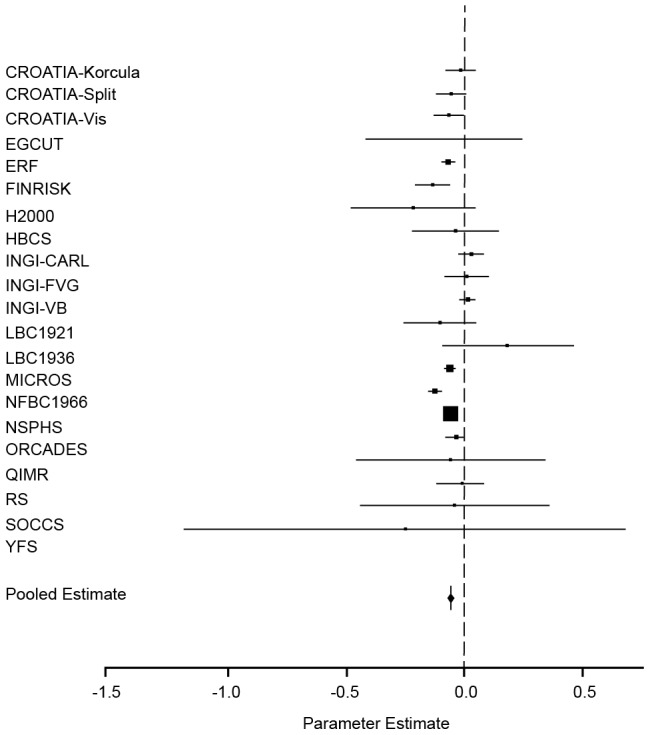
Forest plot of the effect of FROHLD on height.Results of a meta-analysis of the association between FROHLD and height are shown for twenty-one population samples. The model was adjusted for age and sex in all samples. Additionally, it was adjusted for genomic kinship in samples with pairs of related individuals (CROATIA-Korčula, CROATIA-Split, CROATIA-Vis, ERF, FINRISK, HBCS, H2000, INGI-CARL, INGI-FVG, INGI-VB, MICROS, NFBC1966, NSPHS, ORCADES and YFS). The plot shows estimated effect sizes (solid squares) for each population, with 95% confidence intervals (horizontal lines). Each sample estimate is weighted by the inverse of the squared standard error of the regression coefficient, so that the smaller the standard error of the study, the greater the contribution it makes to the pooled regression coefficient. The area of the solid squares is proportional to the weighting given to each study in the meta-analysis. Effect sizes in z-score units (with 95% confidence intervals) are: CROATIA-Korčula = −0.02 (−0.09, 0.04); CROATIA-Split = −0.06 (−0.1, −0.002); CROATIA-Vis = −0.07 (−0.1, −0.01); EGCUT = −0.09 (−0.04, 0.2); ERF = −0.08 (−0.1, −0.05); FINRISK = −0.1 (−0.2, −0.07); HBCS = −0.04 (−0.2, 0.1); H2000 = −0.2 (−0.5, 0.04); INGI-CARL = 0.02 (−0.03, 0.07); INGI-FVG = −0.0001 (−0.08, 0.08); INGI-VB = 0.005 (−0.03, 0.04); LBC1921 = −0.1 (−0.3, 0.04); LBC1936 = 0.2 (−0.1, 0.4); MICROS = −0.06 (−0.08, −0.05); NFBC1966 = −0.1 (−0.2, −0.1); NSPHS = −0.07 (−0.07, −0.06); ORCADES = −0.04 (−0.08, 0.001); QIMR = −0.07 (−0.5, 0.3); RS = −0.02 (−0.1, 0.08); SOCCS = −0.05 (−0.4, 0.3); YFS = −0.3 (−1.2, 0.7).